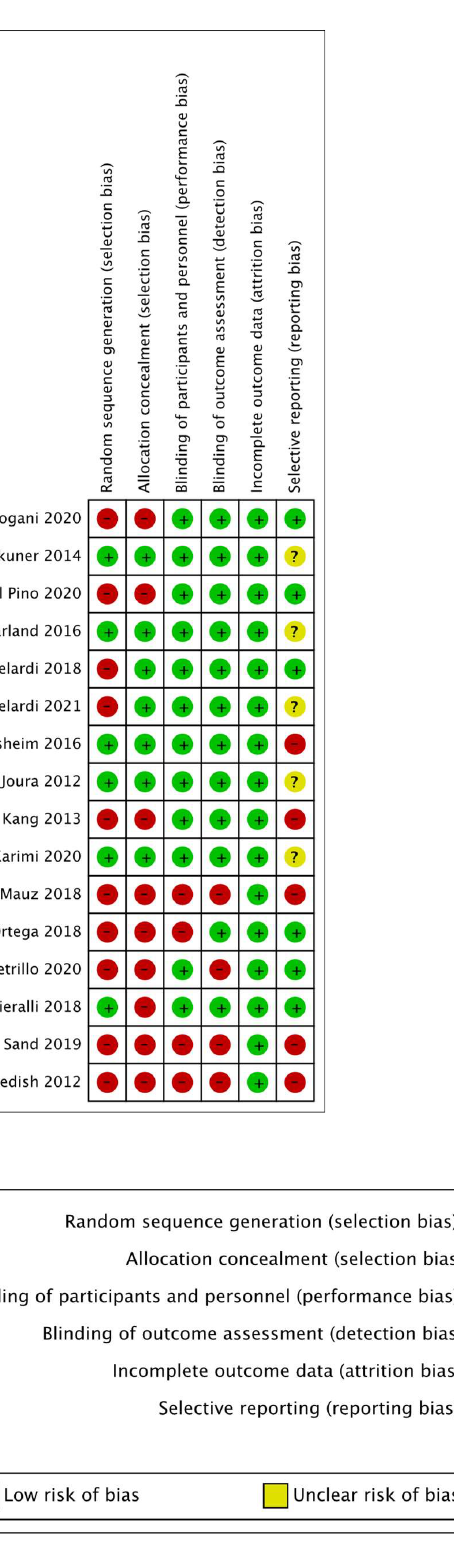
Figure 2. ( A ) Risk of bias summary: authors’ judgments about each risk of bias item for each included study. ( B ) Risk of bias graph: authors’ judgments about each risk of bias item presented as percentages for all included